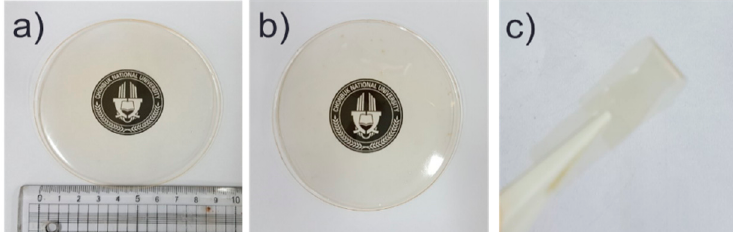
Figure 1. Photographs of membranes; ( a ) CM-PAES X10Y13, ( b ) QN-PAES X10Y13, and ( c ) bending QN-PAES X10Y13.